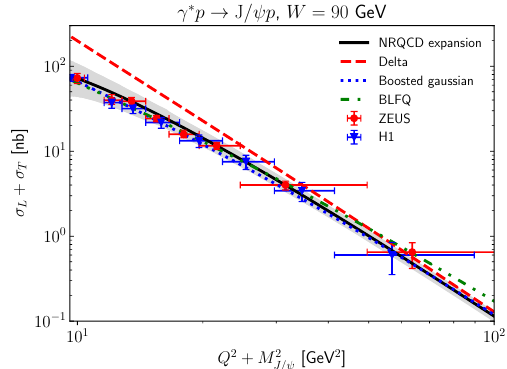
Figure 1: Total exclusive J /ψ production cross section as a function of the photon virtuality [ 6 ]